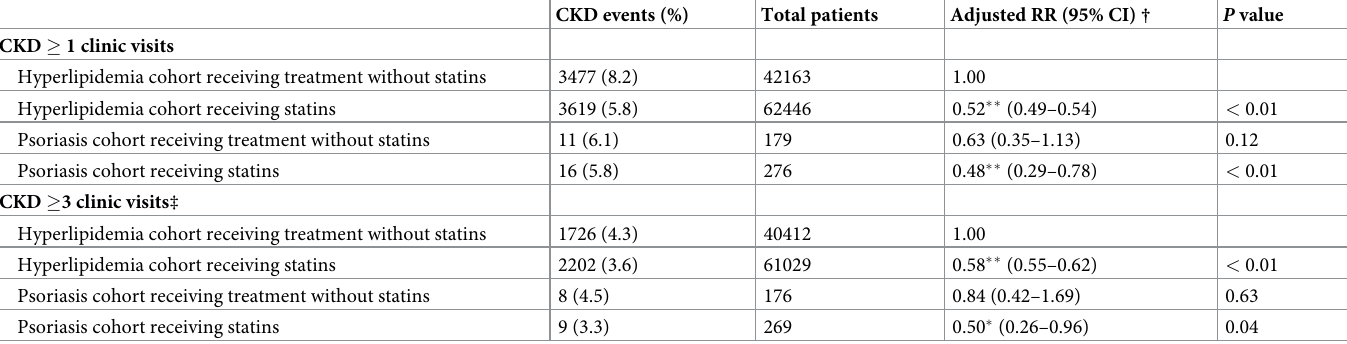
Table 3. Statin treatment for hyperlipidemia and the risk of incident chronic kidney disease.